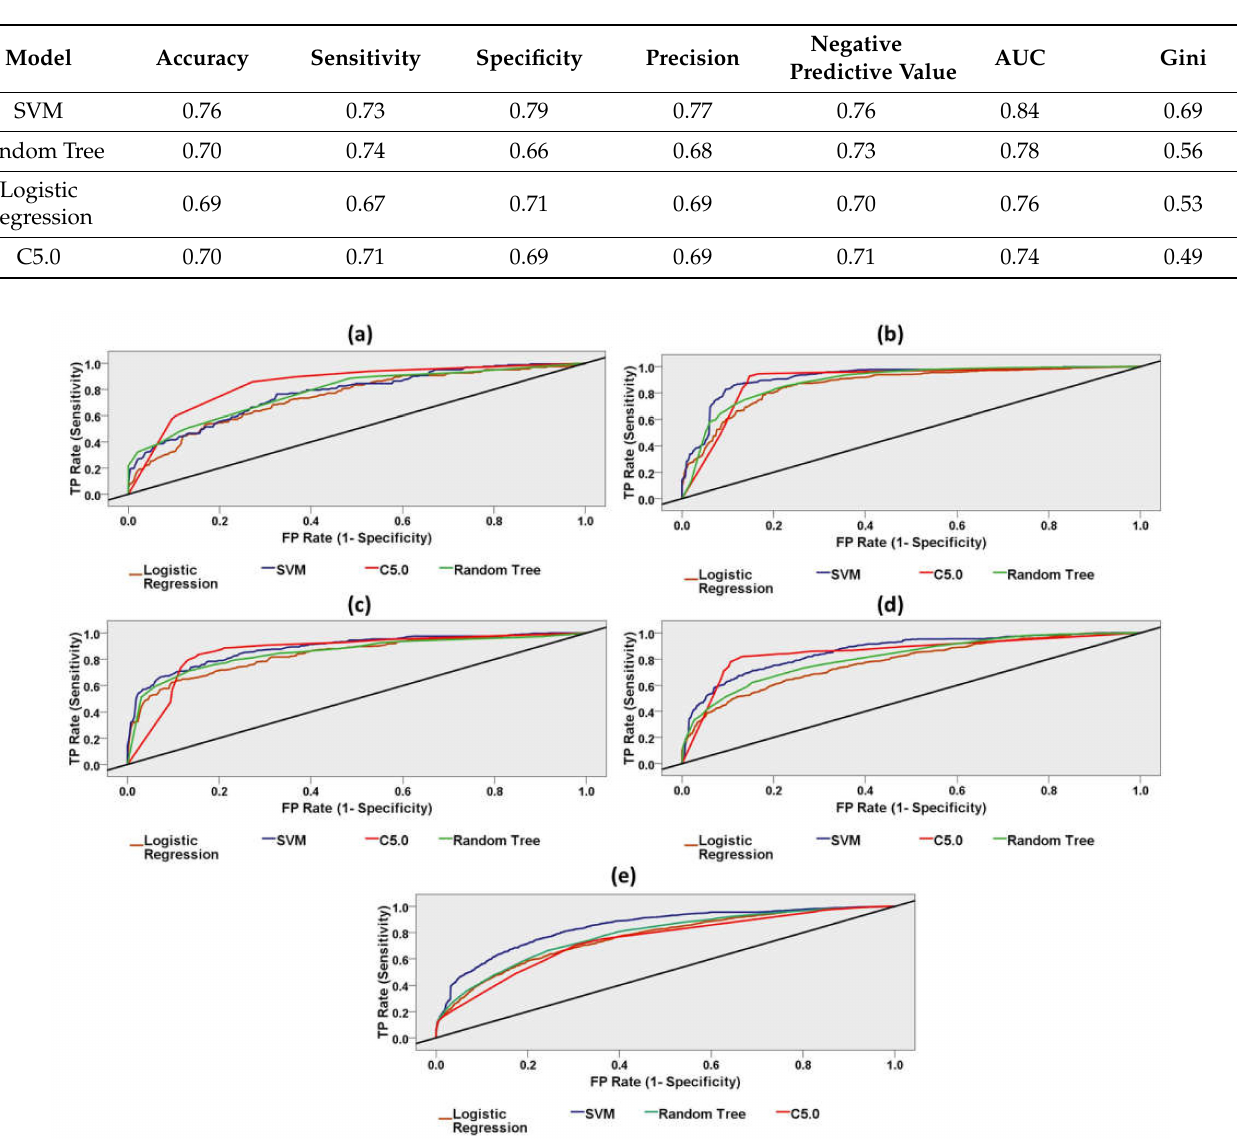
Figure 8. Receiver Operating Characteristic (ROC) curves for four different machine-learning models (Support Vector Machine, Random Trees, Logistic Regression, C5.0). ( a ) ROC curve for resting dataset, ( b ) ROC curve for walking dataset, ( c ) ROC curve for working dataset, ( d ) ROC curve for reading dataset, ( e ) ROC curve for task-independent entire dataset. The area under the ROC curve (AUC) is an indicator of prediction accuracy. C5.0 classified the cognitive reading dataset with the highest AUC (86%) and highest accuracy (ACC: 85%). The diagonal black line is the reference